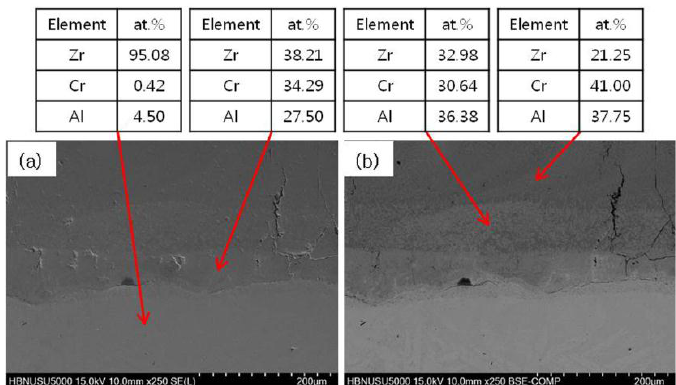
Figure 3. SEM-EDS analyses of laser-coated Zircaloy-4 substrate alloy after the isothermal heating at 1100 °C for 2 h in inert atmosphere: ( a ) bright image; ( b ) backscattered image.